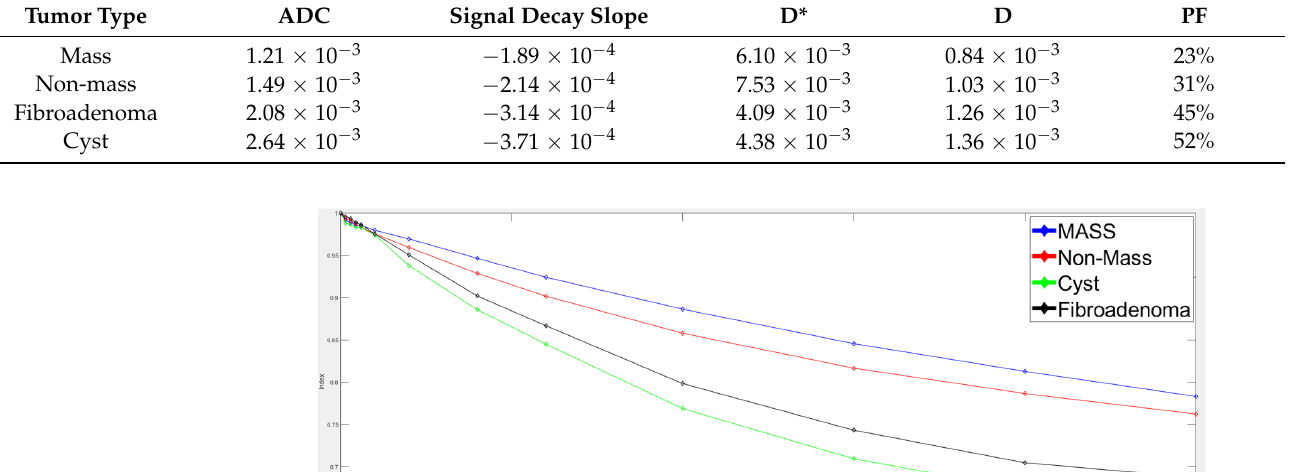
Table 11. Quantitative results for mass, non-mass, fibroadenoma, and cyst tumors. Tumor Type